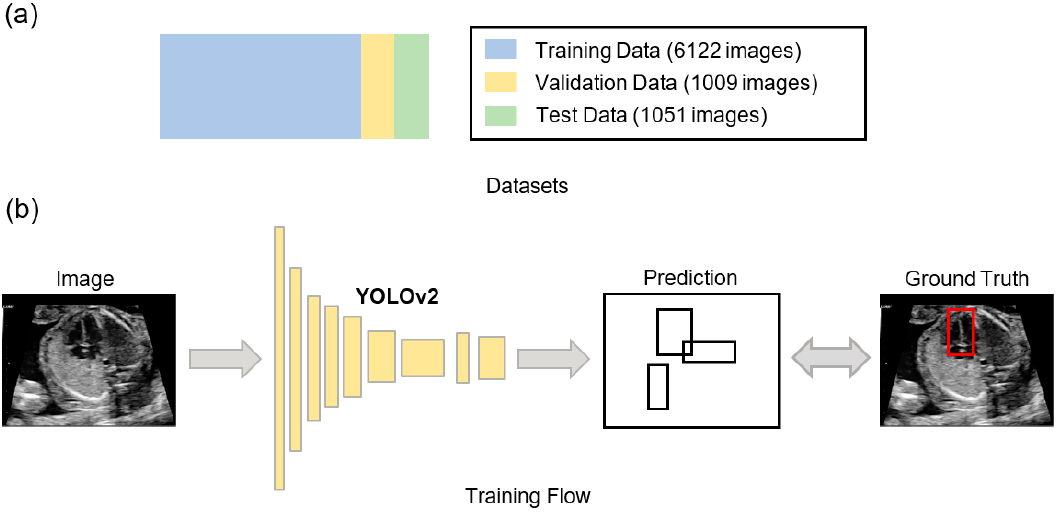
Figure A1. Pretraining for YOLO. ( a ) Datasets for YOLO’s pretraining. The ultrasound images were assigned to 6122 training data, 1009 validation data, and 1051 test data. ( b ) YOLO’s training flow. YOLO was trained by processing the image to calculate the bounding box and comparing it to the ground truth label.